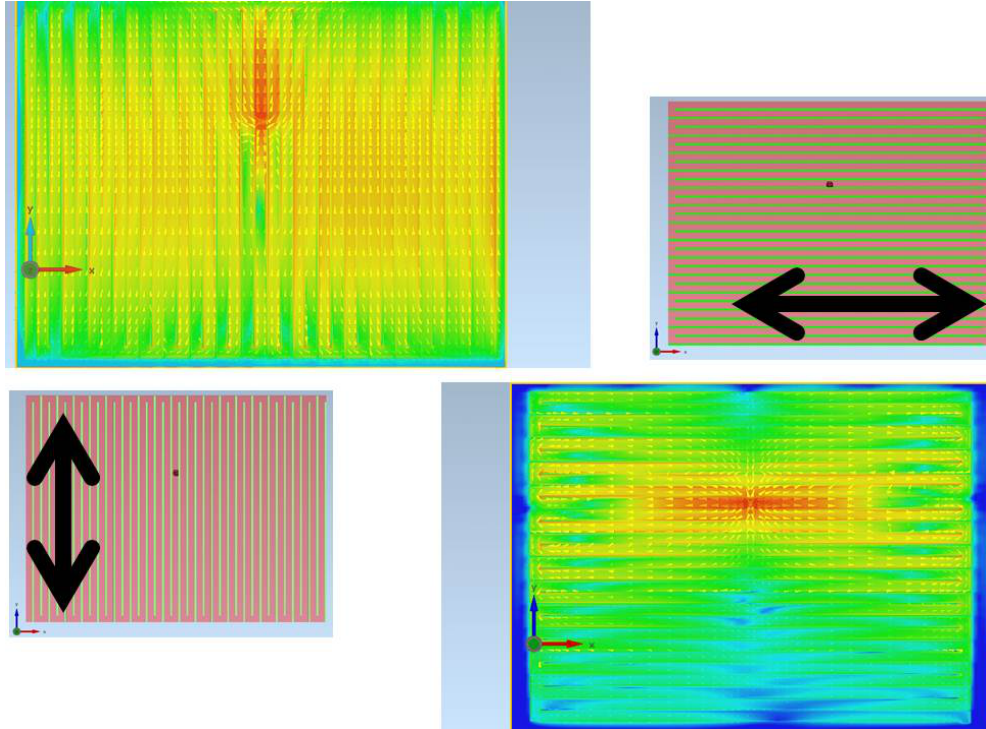
Figure 8. Simulated surface current of two different stitch direction patch